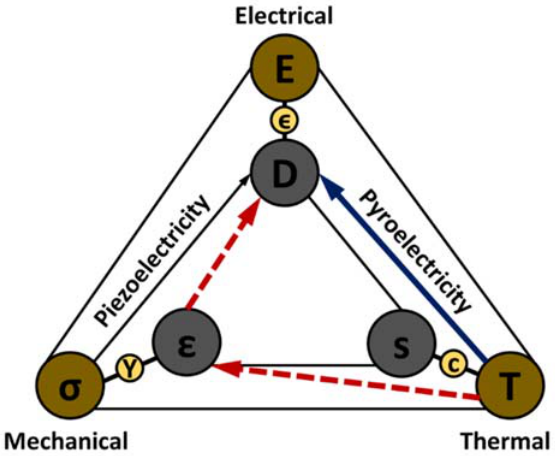
Figure 12. Heckmann diagram illustrating the thermodynamically reversible interactions that may occur among the thermal, mechanical, and electrical properties of a crystal.